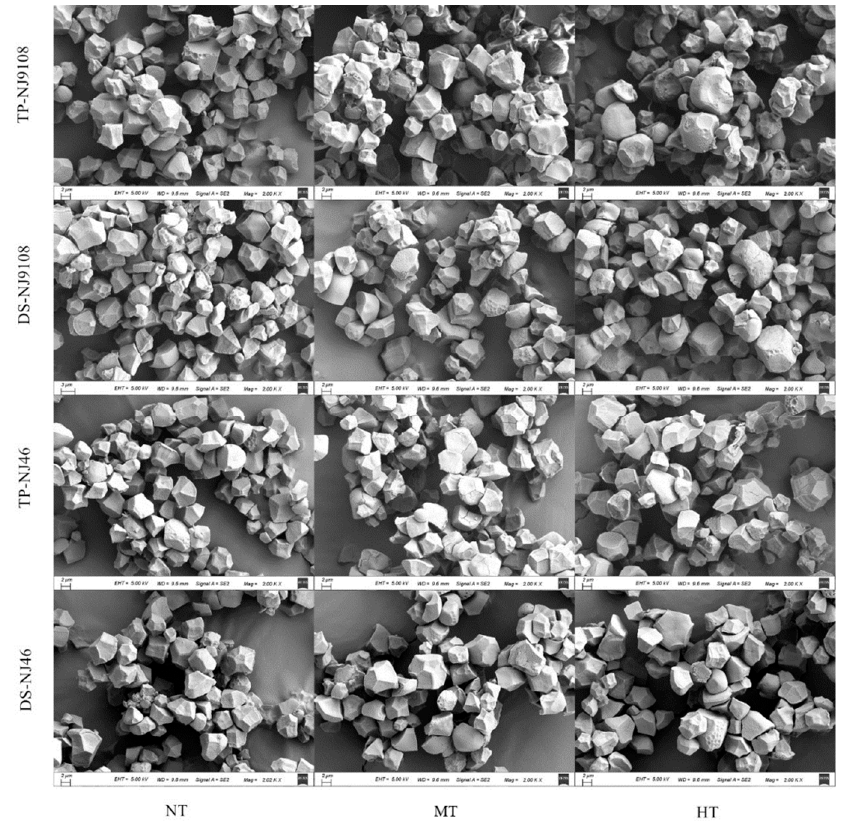
Figure 1. Effects of high temperature on starch morphological structure of japonica rice in early heading stage under transplanting and direct seeding (2000×).